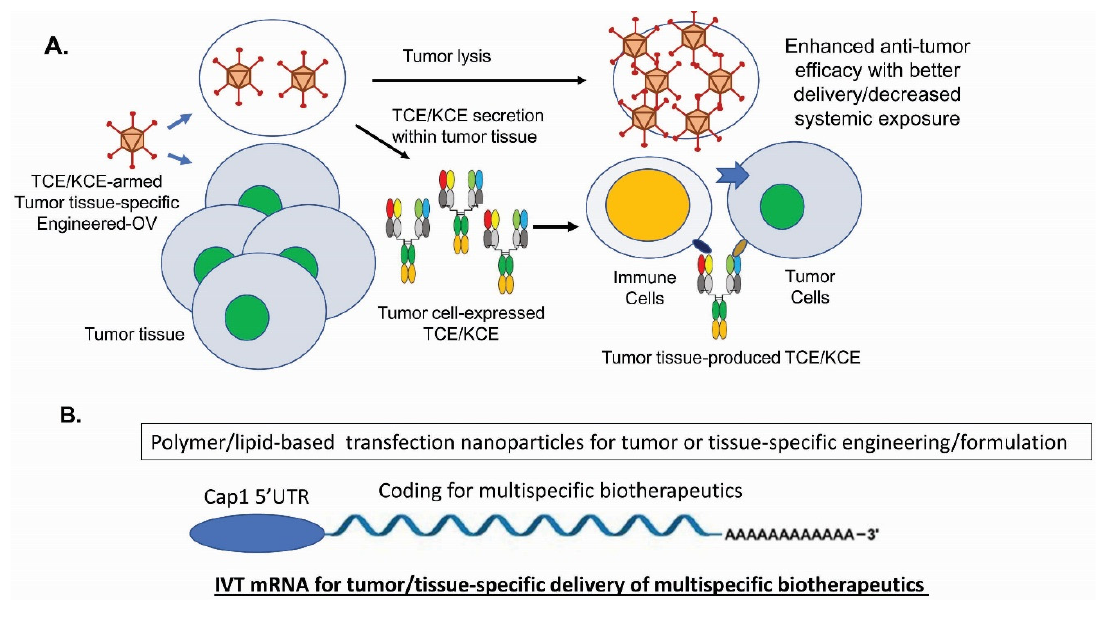
Figure 2. New technologies for multispecific biotherapeutics. ( A ). TCE and KCE-armed oncolytic viruses (OV) [227]. ( B ). In vitro transcribed (IVT) mRNA-encoded multispecific biotherapeutics [228].